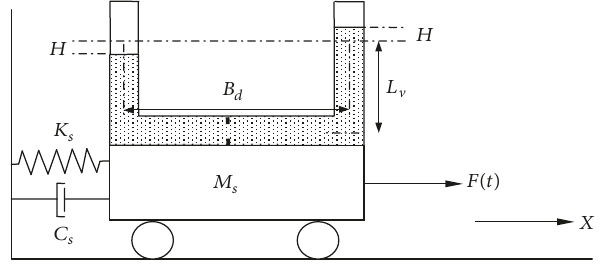
Figure 1: Schematic diagram of TLCD.